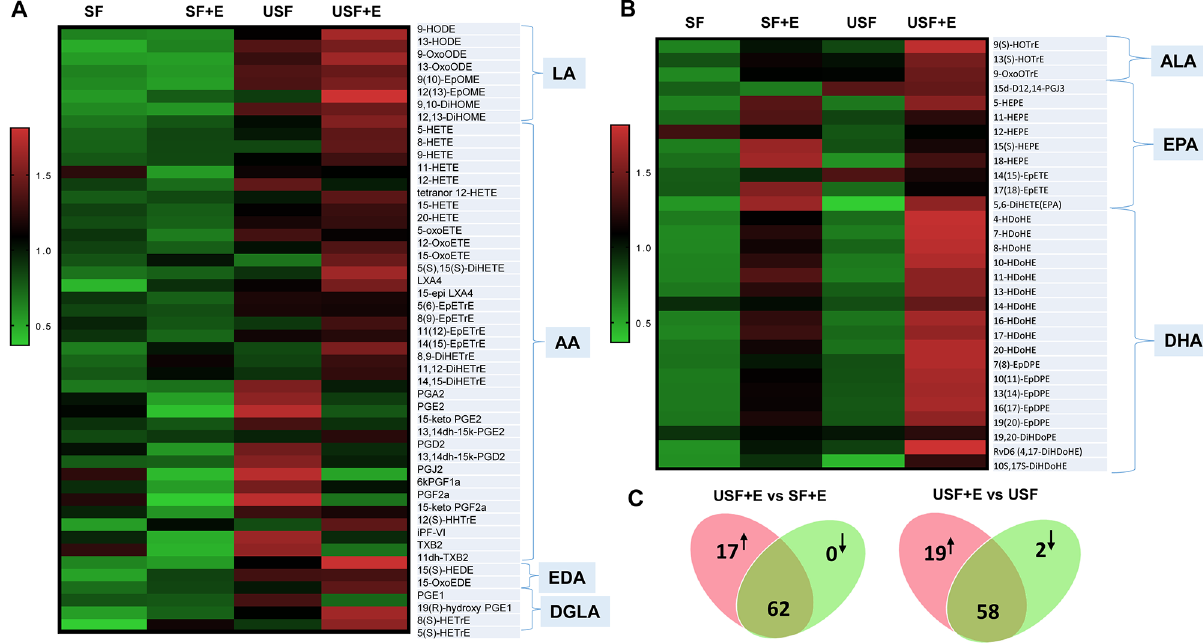
Fig 4. Alterations in hepatic oxylipins caused by chronic-binge ethanol exposure. A, B: Heat maps representing the overall changes in hepatic metabolites derived from ω -6 and ω -3 PUFAs occurred between experimental groups. Results are expressed as a matrix view where rows represent individual metabolites and columns represent group distribution. The intensity of each color denotes the standardized ratio between each value and the average levels of each metabolite across all samples in all groups. C: The diagram summarizing differential levels of all PUFA-derived metabolites between the indicated treatment groups. n = 6 mice per group. AA, arachidonic acid; ALA, α -linolenic acid; DHA, docosahexaenoic acid; DGLA, dihomo- γ -linolenic acid; E, ethanol; EDA, eicosadienoic acid; EPA, eicosapentaenoic acid; SF, saturated fat; USF, unsaturated fat; Individual oxylipin abbreviations see in S2 and S4